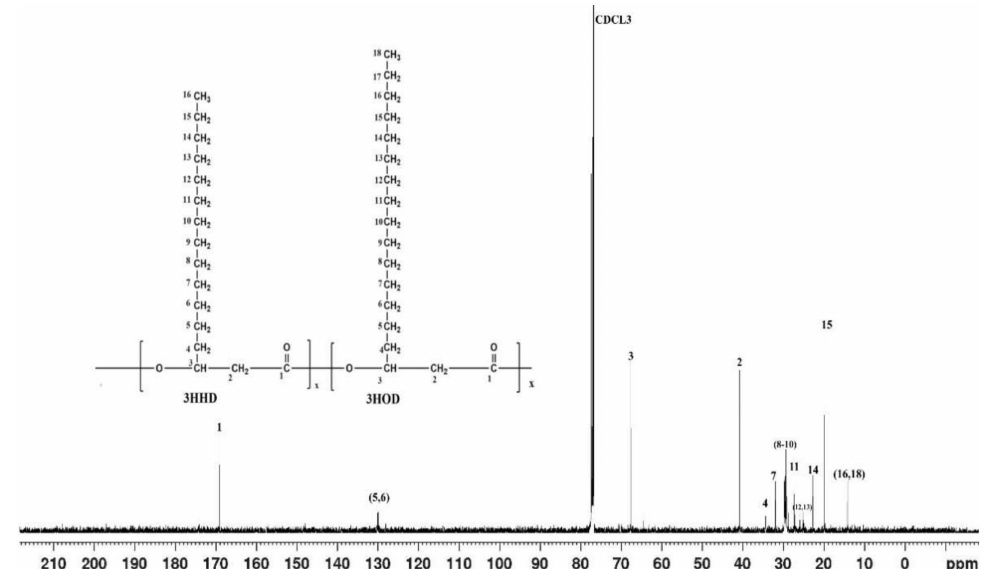
Figure 3. The 13 C NMR spectrum of the PHA produced by Isolate SPD2 ( Acinetobacter sp. Strain AAAID-1.5) in a fermentation medium containing waste transformer oil as the sole carbon substrate.